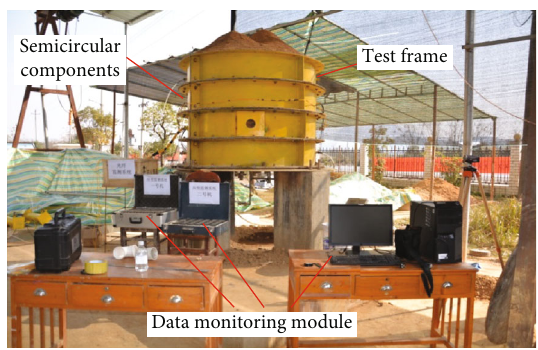
Figure 1: Model test